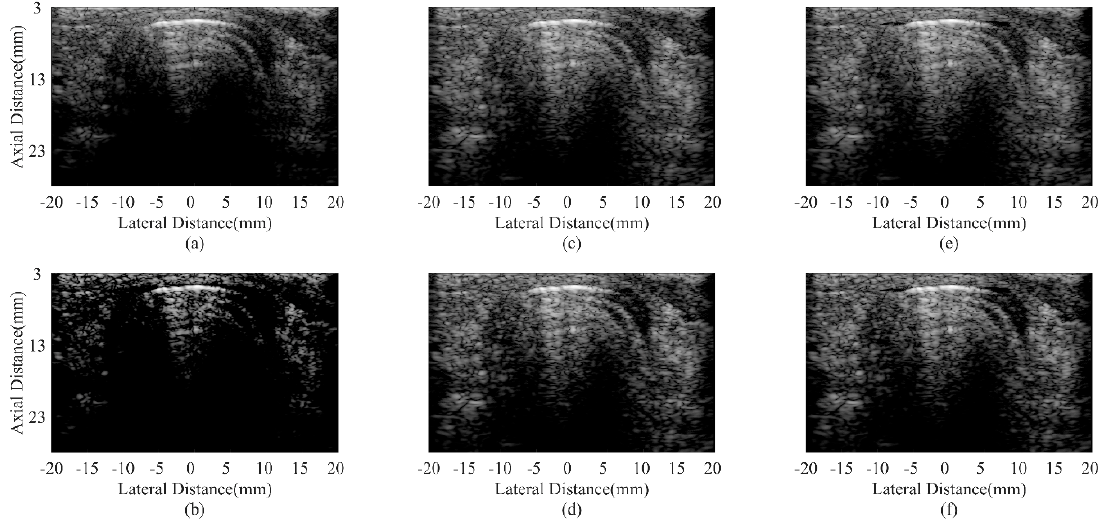
Figure 10. In vivo human thyroid images using different beamformers: ( a ) DAS, ( b ) CF, ( c ) JTR-MV, ( d ) JTR-MV GCF, ( e ) JTR-ESBMV, ( f ) JTR-ESBMV GCF. All images are shown with a dynamic range of 60 dB.